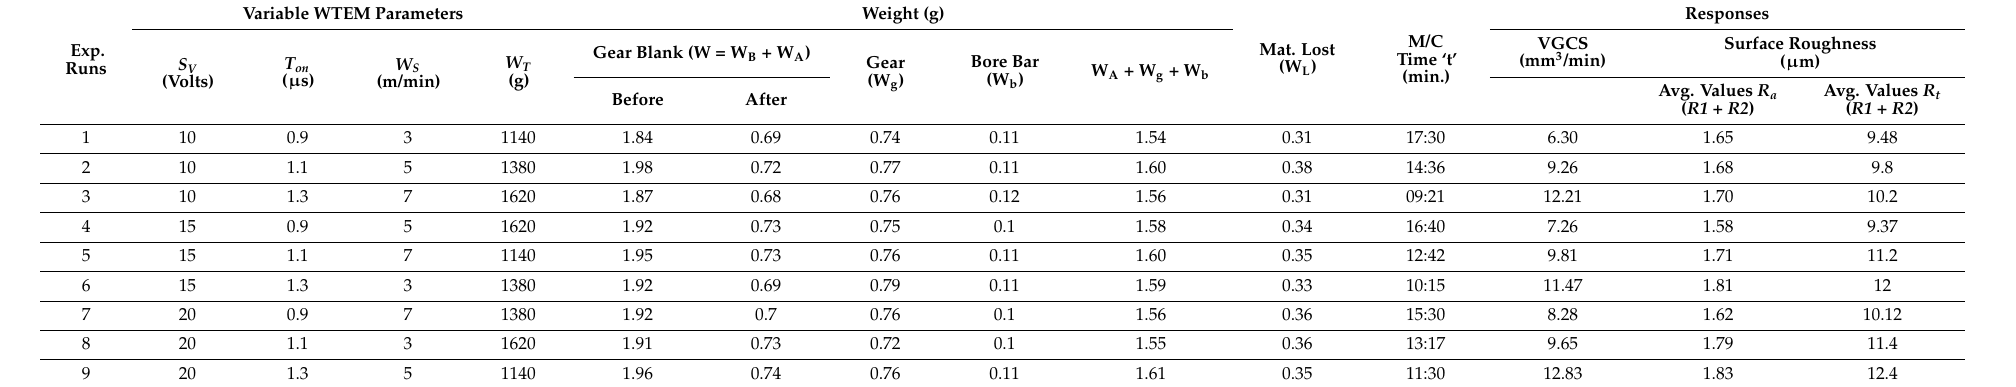
Table A1. Values of variable WTEM parameters for nine experimental runs and corresponding average values (i.e., replicates R1 and R2 ) of considered responses for miniature gear fabrication.